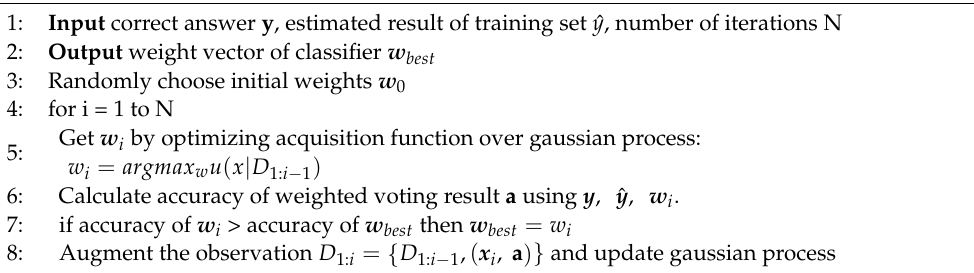
Algorithm 3 Bayesian Optimization for Weights of Each